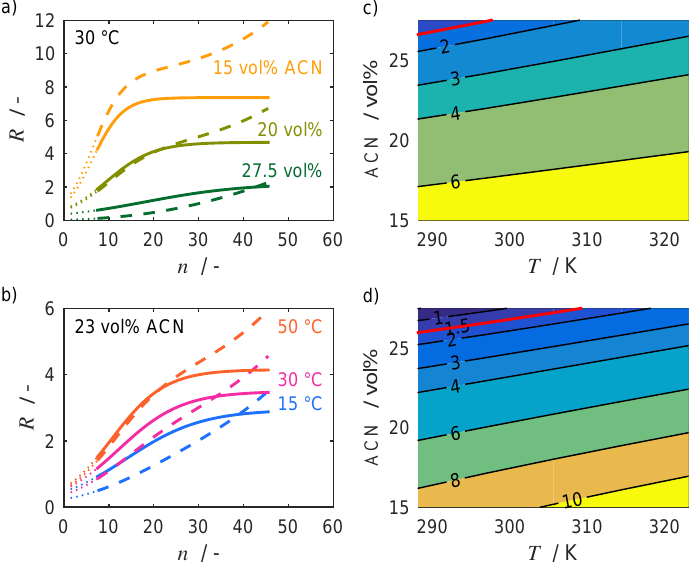
Figure 8. Prediction of peak resolution R . Left —Resolution R versus degree of polymerization n for different conditions: ( a ) role of mobile phase composition for constant T , ( b ) role of T at constant mobile phase composition. Solid lines— R calculated using average stage number of NTP = 9700, dashed— R calculated using NTP interpolation, dotted—extrapolation for small homologs not cov- ered by the model parametrization. Right —Contour maps of resolution achievable between the homologs n = 32 and n = 33: ( c ) Calculated using average NTP = 9700, ( d ) using NTP interpolation. The red lines mark conditions where baseline resolution ( R =1.5) is